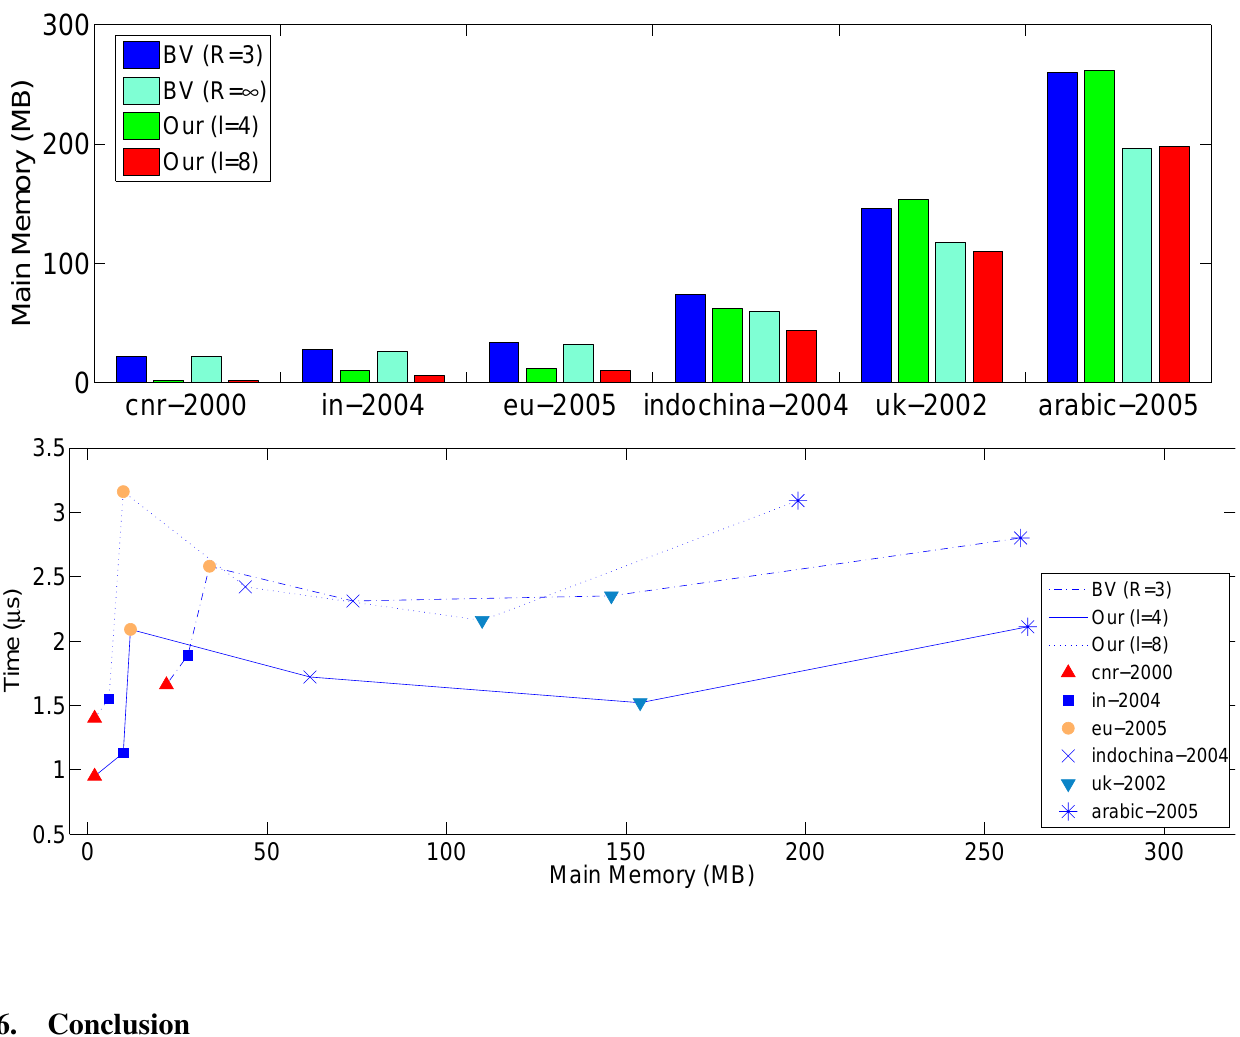
Figure 5. Main memory usage (top) by BV and the present method and the space-time tradeoff